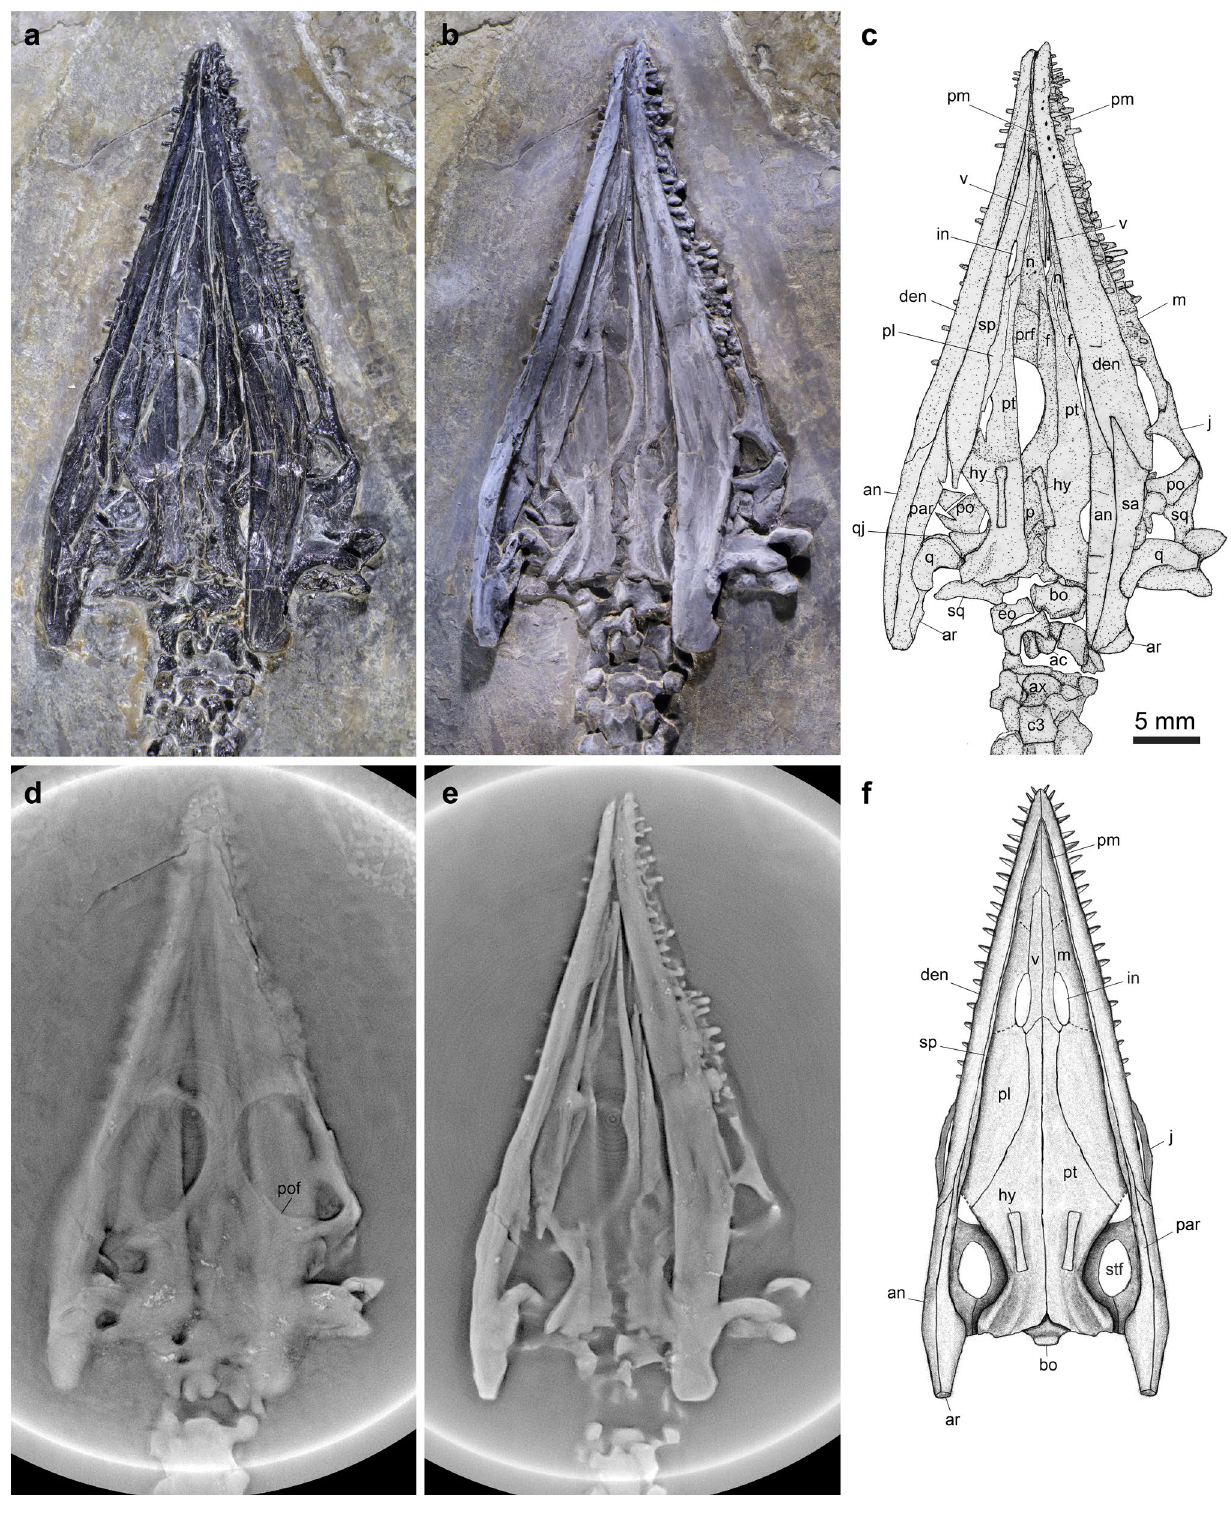
Figure 3. Skull and mandible of Luopingosaurus imparilis gen. et sp. nov., IVPP V19049. Head before ( a ) and after ( b ) dusted with ammonium chloride. ( c ), Line- drawing. ( d , e ), two computed laminography scanning slices. ( f ), reconstruction in ventral view. ac, acetabulum; an, angular; ar, articular; ax, axis; c, cervical vertebra; den, dentary; eo, exoccipital; f, frontal; hy, hyoid; in, internal naris; j, jugal; m, maxilla; n, nasal; p, parietal; par, prearticular; pof, postfrontal; prf, prefrontal; pt, pterygoid; q, quadrate; qj, quadratojugal; sa, surangular; sp, splenial; sq, squamosal; stf, supratemporal fossa; v,